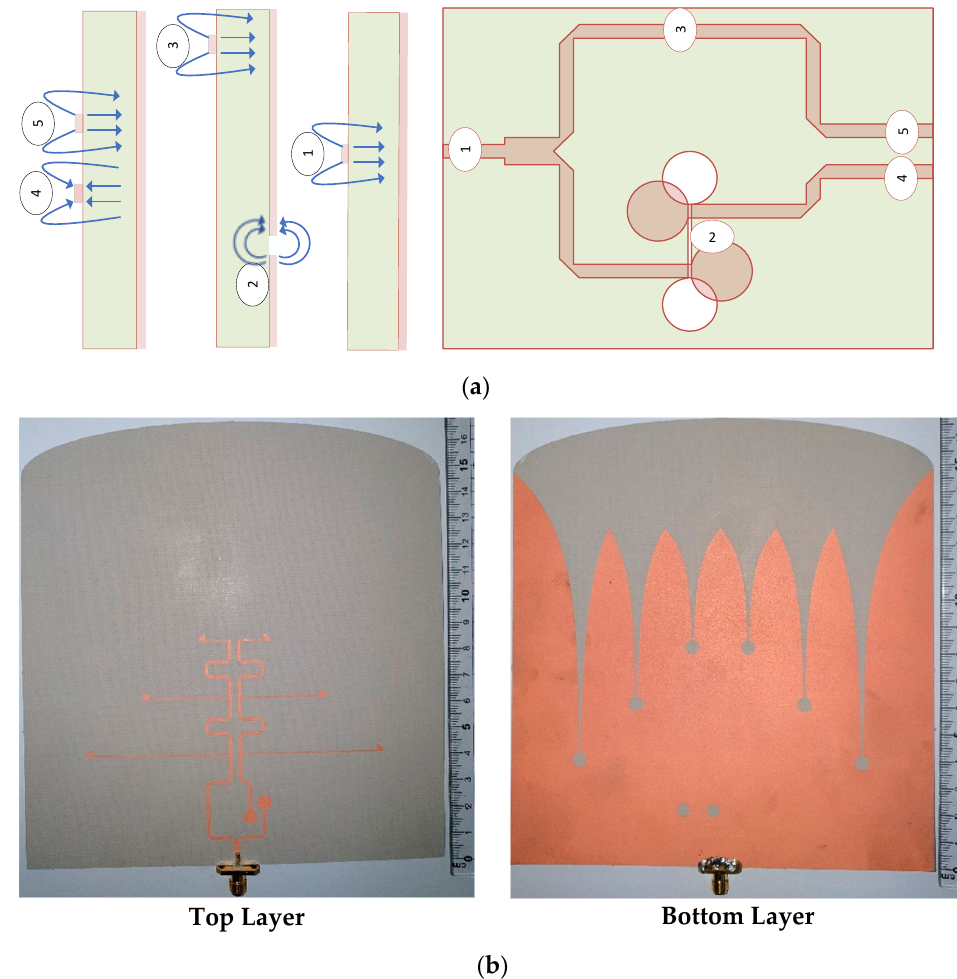
Figure 2. Proposed antenna with power divider: ( a ) power divider with E-field lines distribution at